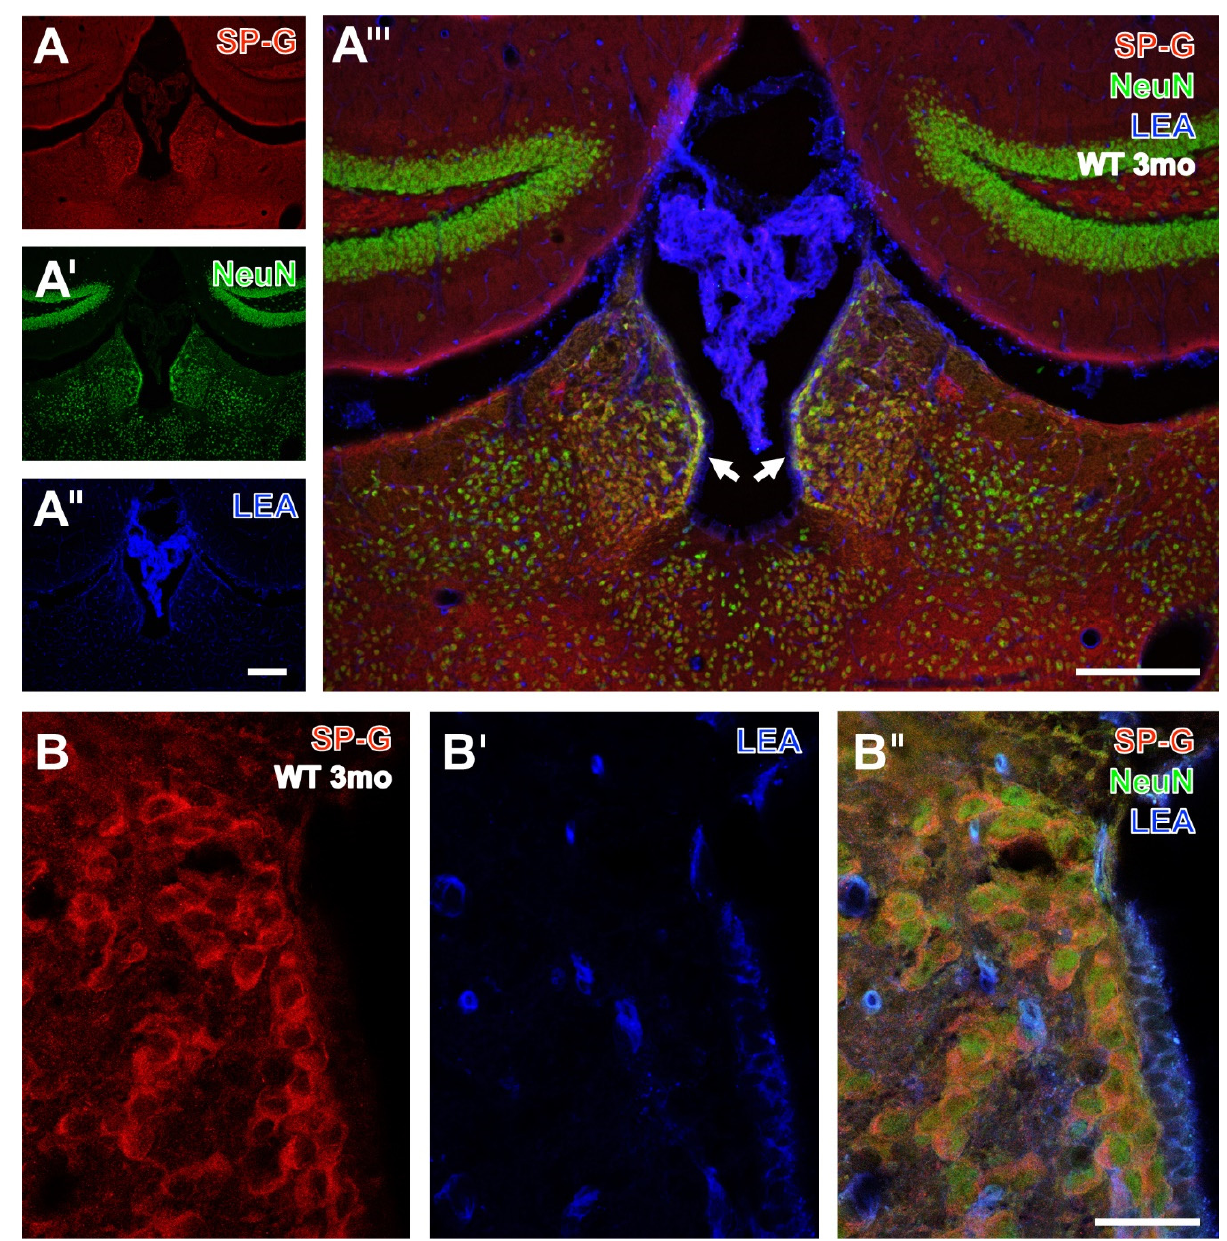
Figure 1. Triple fluorescence labeling of SP-G, LEA-positive vessels, and NeuN in forebrains from 3 month-old WT mice. SP-G-ir ( A ) appears strongest in cells of the habenula, comprises a moderately stained dentate gyrus and a weaker marked granular layer in the hippocampus, and appears mostly lacking in the plexus choroideus. NeuN counterstaining ( A’ ) is most prominent in the granular layer with densely packed neuronal somata but indicates also numerous neurons in the habenula and predominantly its lateral part, as well as in the adjacent paraventricular and lateral posterior nuclei of the thalamus. Concomitant labeling with the tomato lectin LEA ( A’’ ) reveals vessels in habenula and hippocampus but is much heavier in the plexus choroideus, which is confirmed by the overlay of staining patterns ( A’’’ ) that also shows numerous yellowish neurons co-expressing SP-G and NeuN, predominantly in the medial habenula (arrows) and in the paraventricular thalamic nucleus. At a high magnification, confocal laser scanning microscopy reveals SP-G-ir in the rim of cells ( B ) while NeuN-ir remains restricted to the nuclear surroundings ( B’ ) and the overlay clearly verifies the co-expression of SP-G and NeuN in several neurons counterstained by the endothelial labeling with LEA in blue. Scale bars: A’’ (also valid for A , A’ ) = 200 µm, A’’’ = 200 µm, B’’ (also valid for B , B’ ) = 25 µm.